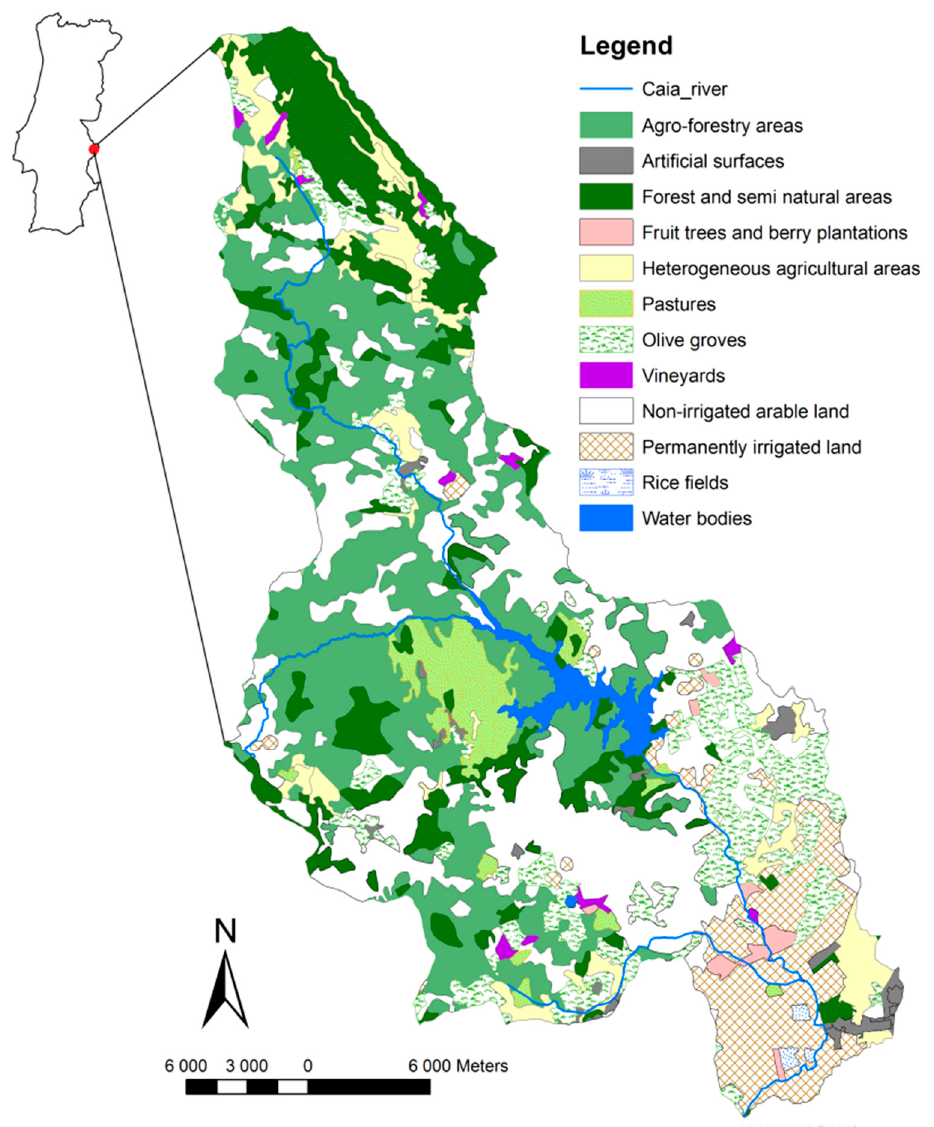
Figure 1. Caia River basin and land use according to the coordination of information on the environment (CORINE) programme land cover project in 2012. Table 1. Land use within Caia River basin and structure of agricultural land according to the coordination of information on the environment (CORINE) programme land cover project in 1990 and 2012.